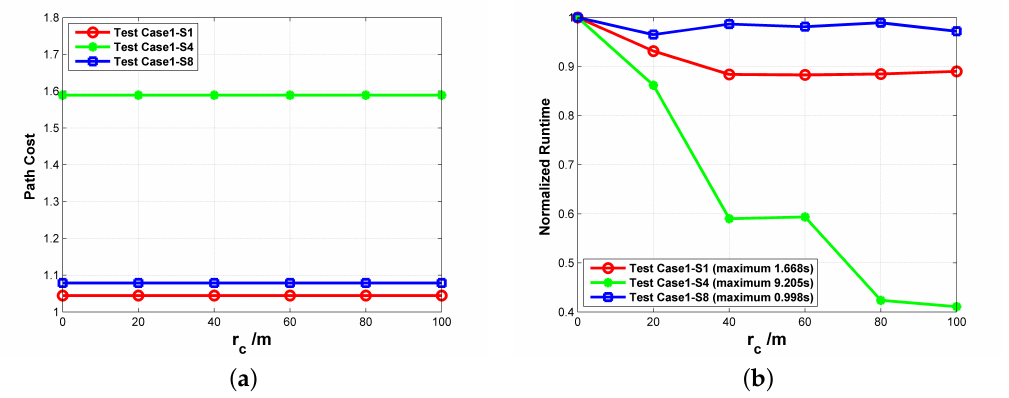
Figure 16. Influence of nearby radius r c on the designed path. ( a ) influence on path cost; ( b ) influence on computational time.